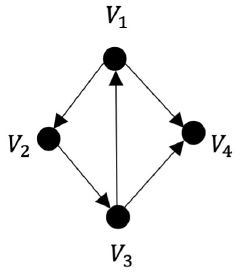
Figure 3. An example of a fuzzy graph.